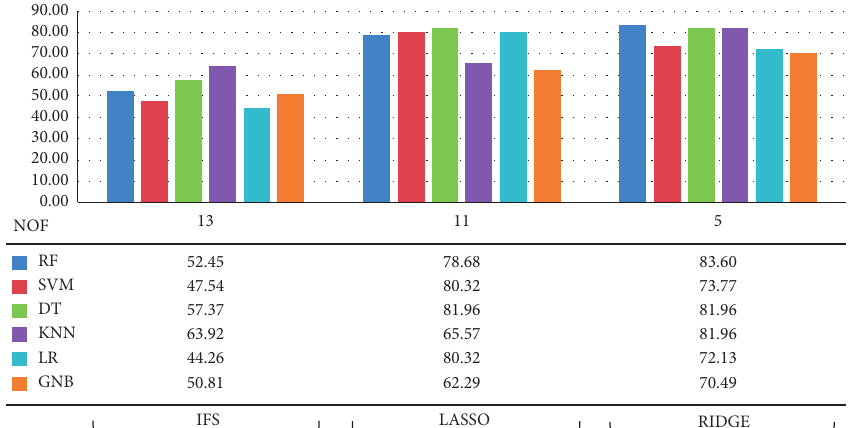
Figure 6: Classification accuracies of reduced feature subsets using wrapper-based methods with RF, SVM, DT, KNN, LR, and GNB (NOF: number of features, IFS: initial feature set, Lasso: Lasso regression, Ridge: ridge